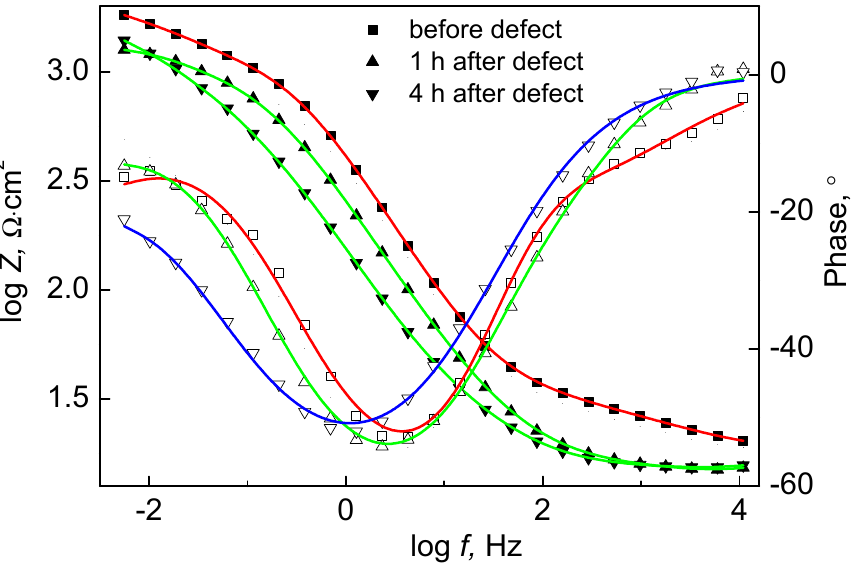
Figure 8. Impedance spectra of Fe/P-Mo in a 0.5 M NaCl solution before and after sample scratching.